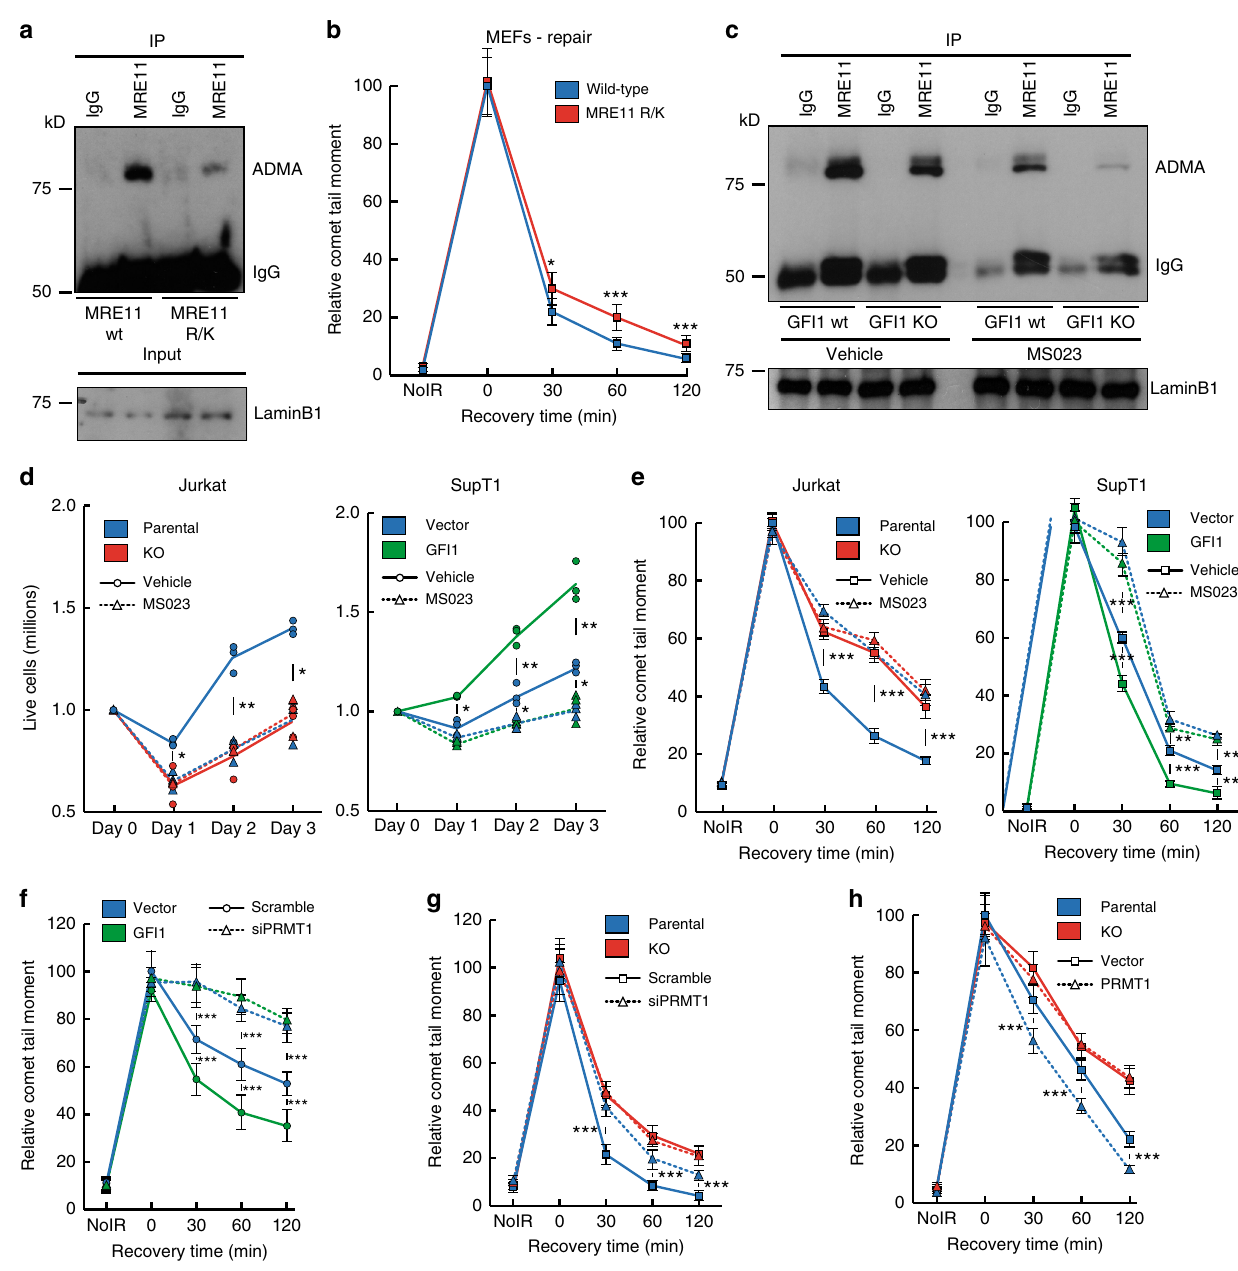
Fig. 6 GFI1 ’ s role in DNA Repair is mediated through PRMT1 activity. a Nuclear extracts were prepared from MEFs expressing an R/K mutant form of MRE11 and wild-type control cells. Extracts were immunoprecipitated for MRE11 and blotted for ADMA. b MEFs expressing an R/K mutant form of MRE11 and wild-type control cells were exposed to 5 Gy IR and allowed to recover for the indicated time. Cells were then lysed and analyzed by alkaline Comet assay. Comet tail moment averages are shown. One of three replicate experiments is shown. Error bars represent s.d. * p < 0.05, ** p < 0.01, *** p < 0.001 on a Welch corrected T -test. c GFI1 KO Jurkat cells and parental control cells were treated for 48 h with 500 nM MS023 inhibitor. Nuclear extracts were then immunoprecipitated for MRE11 and blotted for ADMA. d GFI1 KO Jurkat cells and parental control cells (left) and SupT1 overexpressing GFI1 and vector control cells (right) were pre-treated with 500 nM of MS023 inhibitor or vehicle were seeded at 1 million cells per ml and exposed to 5 Gy IR. Cells were counted each following day. Dashed lines show average cell numbers and individual data points of a triplicate experiment are shown. e Cells as in d were exposed to 5 Gy IR and allowed to recover for the indicated time. Cells were then lysed and analyzed by Comet assay as in b . f SupT1 overexpressing GFI1 and vector control cells were electroporated with an siRNA against PRMT1. Electroporated cells were FACS sorted 24 h later. 24 additional hours later, cells were exposed to 5 Gy IR, allowed to recover for the indicated time, then lysed and analyzed by alkaline Comet assay as in b . g GFI1 KO Jurkat cells and parental control cells were treated as in f and analyzed by alkaline Comet assay as in b . h GFI1 KO Jurkat cells and parental control cells were electroporated with a pcDNA3.1 plasmid expressing PRMT1 or a vector control. Electroporated cells were FACS sorted 24 h later. 24 additional hours later, cells were exposed to 5 Gy IR, allowed to recover for the indicated time, then lysed and analyzed by alkaline Comet assay as in